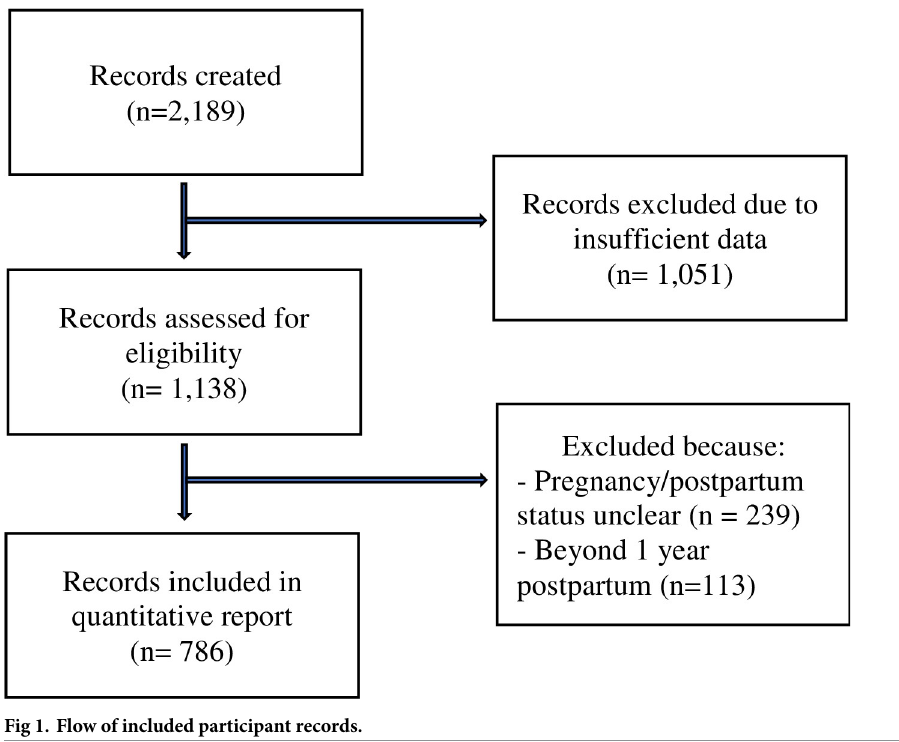
Fig 1. Flow of included participant